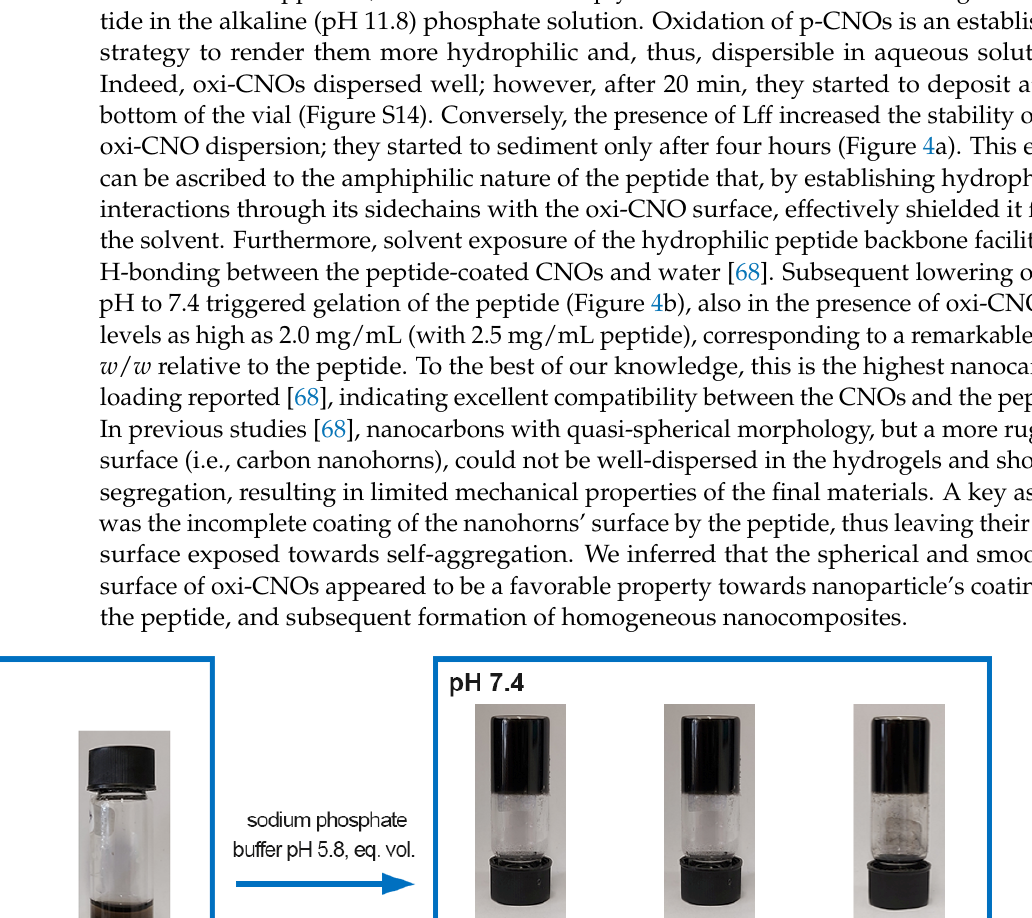
9 of 19 Figure 3. Spectra of p ‐ CNOs, oxi ‐ CNOs and amino ‐ PEG ‐ CNOs from analysis by ( a ) ATR ‐ FTIR and ( b ) Raman spectroscopy.